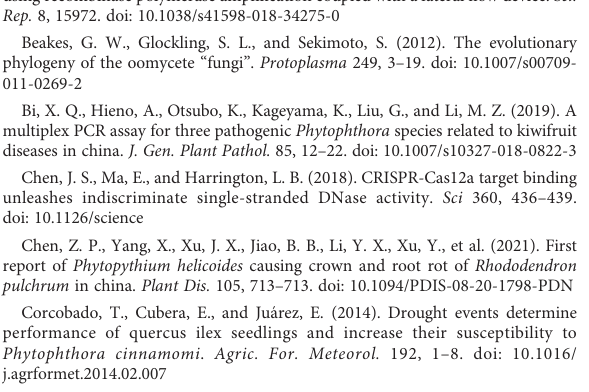
SUPPLEMENTARY TABLE 2 Ten loci were randomly selected for screening by conventional PCR assays from more than 1,000 Phytophthora cinnamomi – speci fi c putative